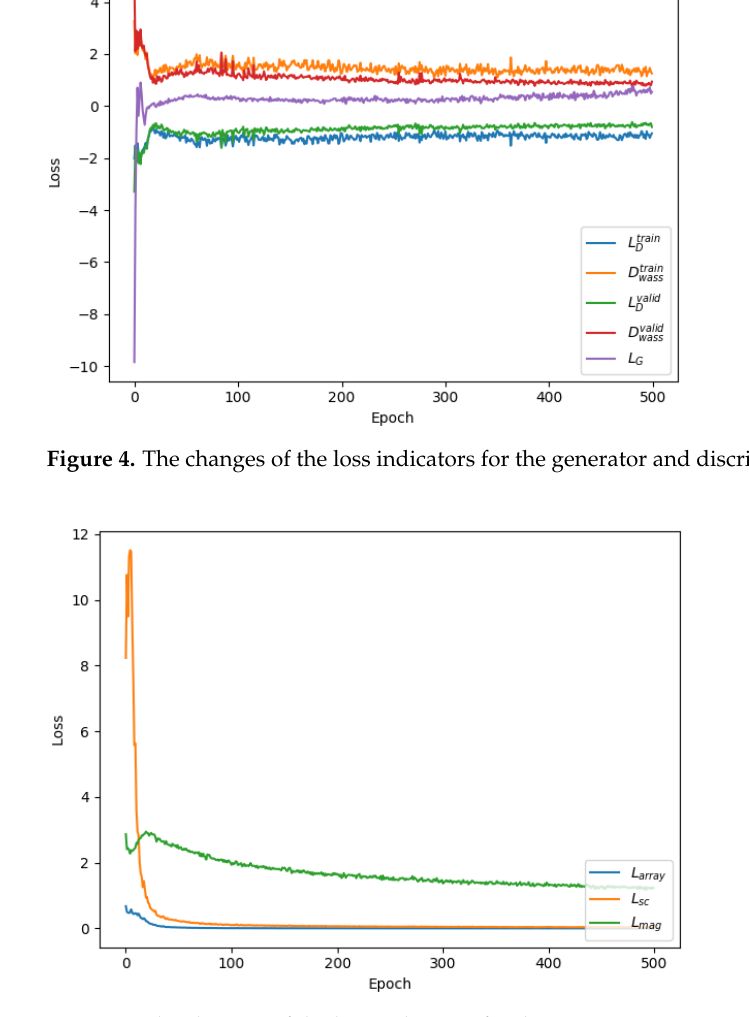
Figure 5. The changes of the loss indicators for the